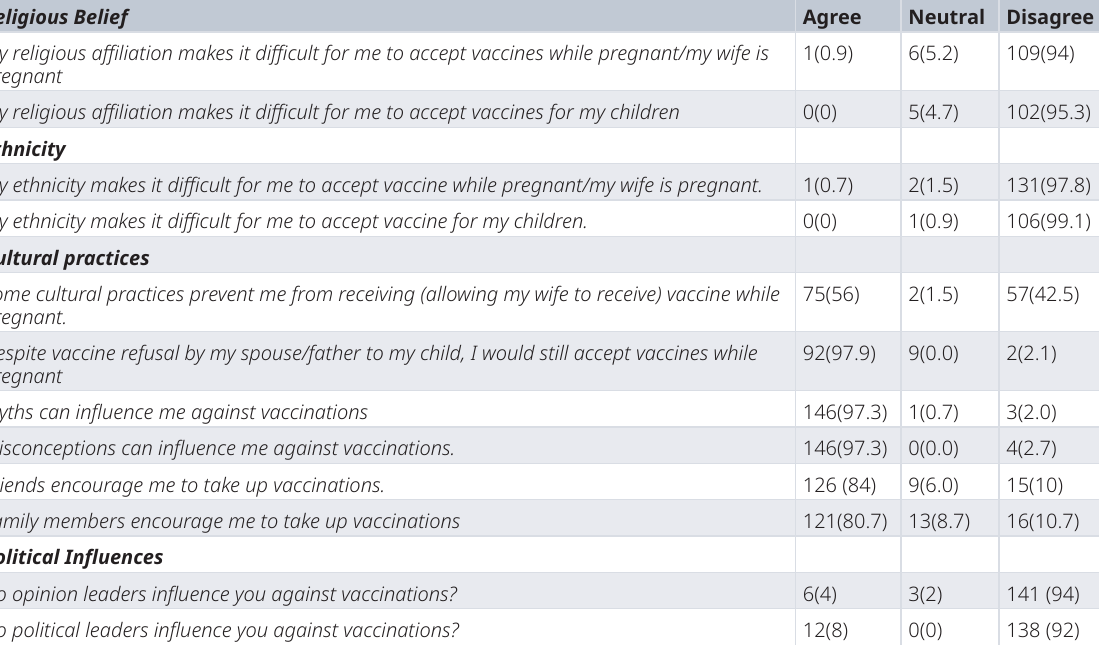
Table 3. Antenatal care (ANC) provider religious cultural and political belief on vaccination. Religious